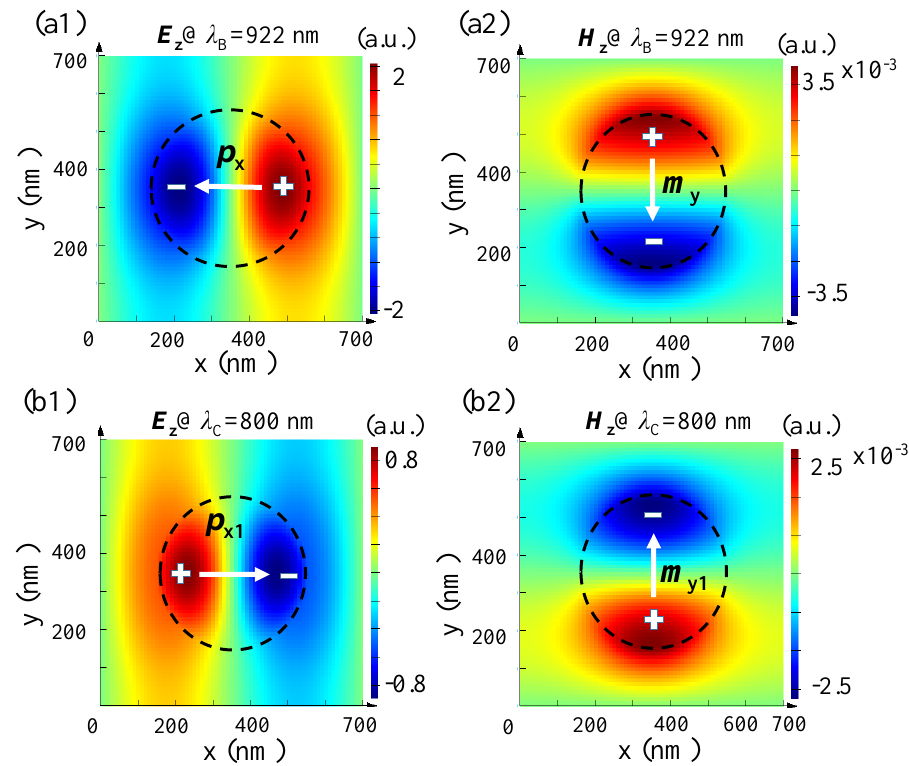
forward incidence.